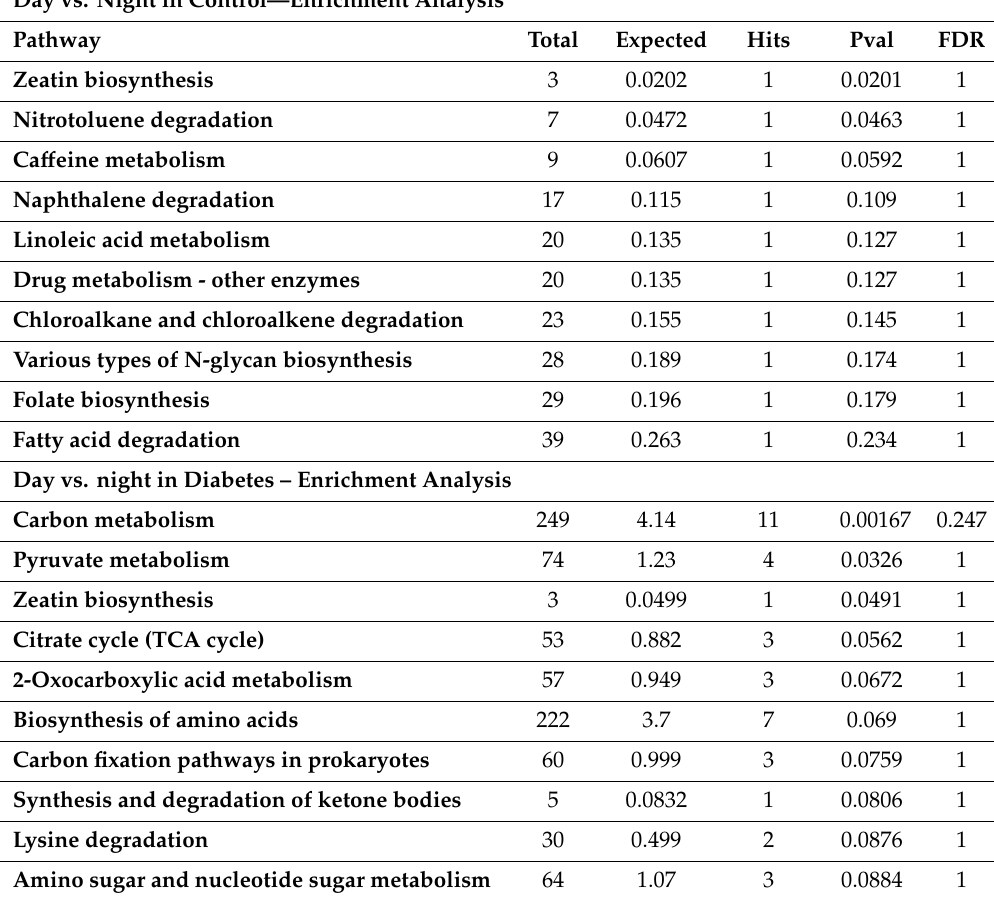
Table 2. Enrichment analysis of predicted pathways for bacterial functions that were di ff erent in day vs night in control and type 2 diabetic